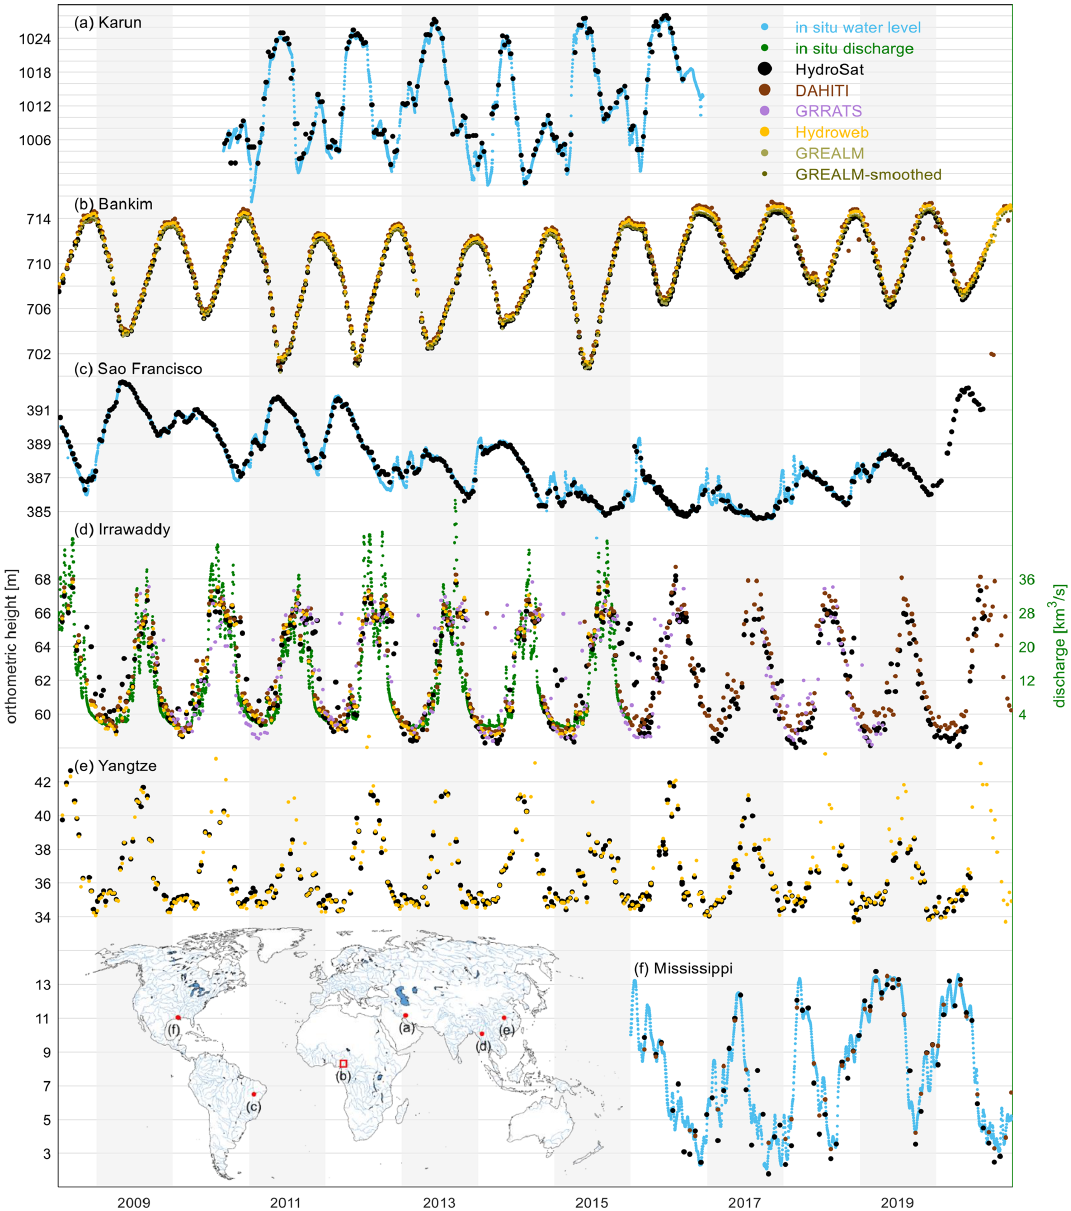
Figure 1. Standard-rate altimetric water level time series over the Karun river (Iran) from Jason-2, Lake Bankim (Cameroon) from Jason-2 and Jason-3, the São Francisco River (Brazil) from Jason-2 and Jason-3, the Irrawaddy River (Myanmar) from Jason-2 and Jason-3, the Yangtze River (China) from Jason-2 and Jason-3, and the Mississippi River (US) from Sentinel-3A.